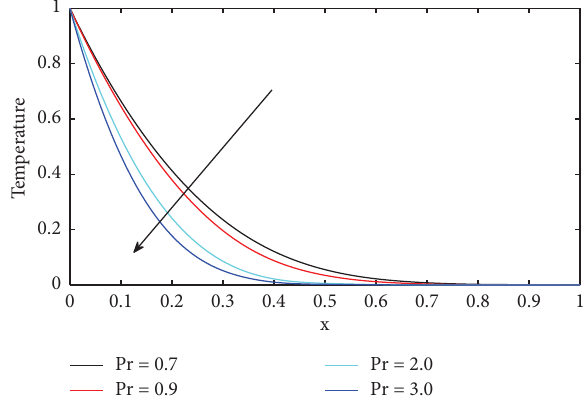
Figure 19: Temperature profles for diferent values of Pr .